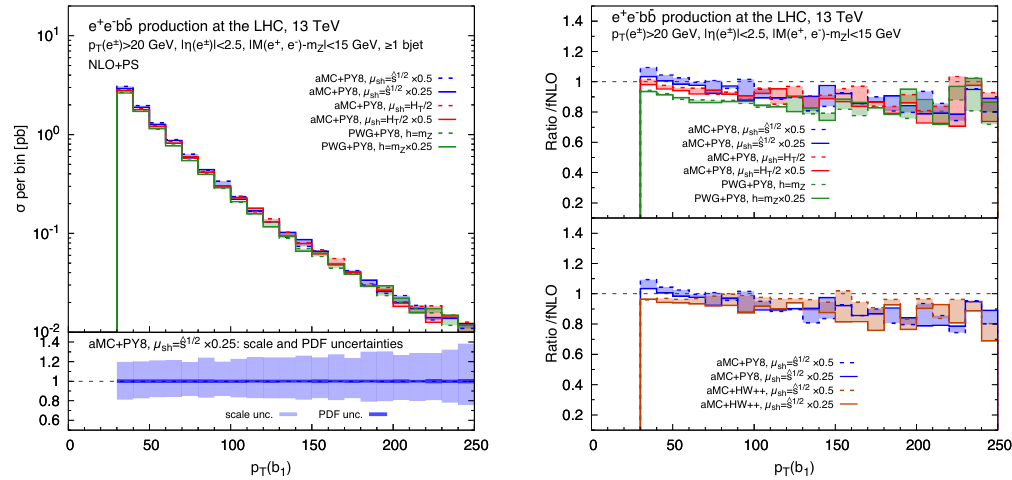
Figure 27 . Transverse momentum distribution of the hardest b jet.